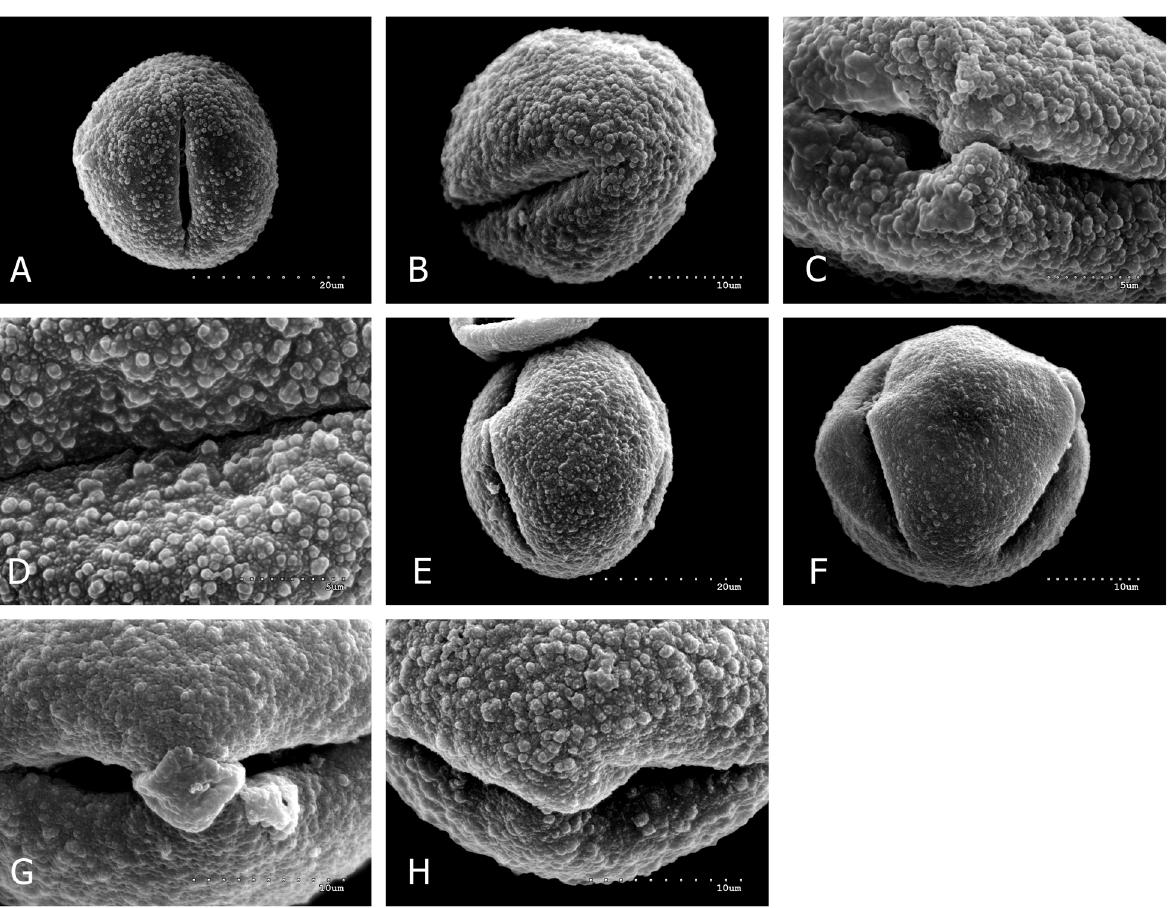
Fig 2. Q . petraea × Q . pubescens , A-D. A, equatorial view; B, polar view with one ectocolpus; C, ectocolpus and exine granulate- verrucate ornamentation; D, exine ornamentation details — see (Fig 1E); Q . robur × Q . petraea , E-H. E, equatorial view, F, polar view with two ectocolpi; G, ectocolpus and exine granulate-verrucate ornamentation; H, exine ornamentation details — see (Fig 1E).